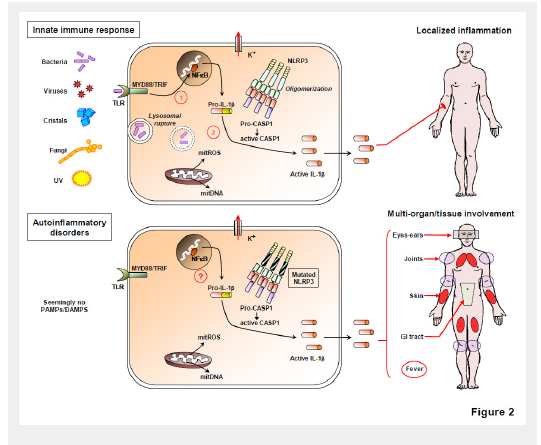
Current models of inflammasome activation involve K + efflux, release of reactive oxygen species (ROS) and mitochondrial DNA (mtDNA) in the cytosol. Upon encounter of PAMPs/DAMPs including microbes or crystals, the NLRP3–inflammasome is activated and the resulting IL-1β release triggers localised inflammatory responses. In contrast, the NLRP3–inflammasome is constitutively activated, resulting in multi-organ involvement and periodic fever in patients suffering from autoinflammatory